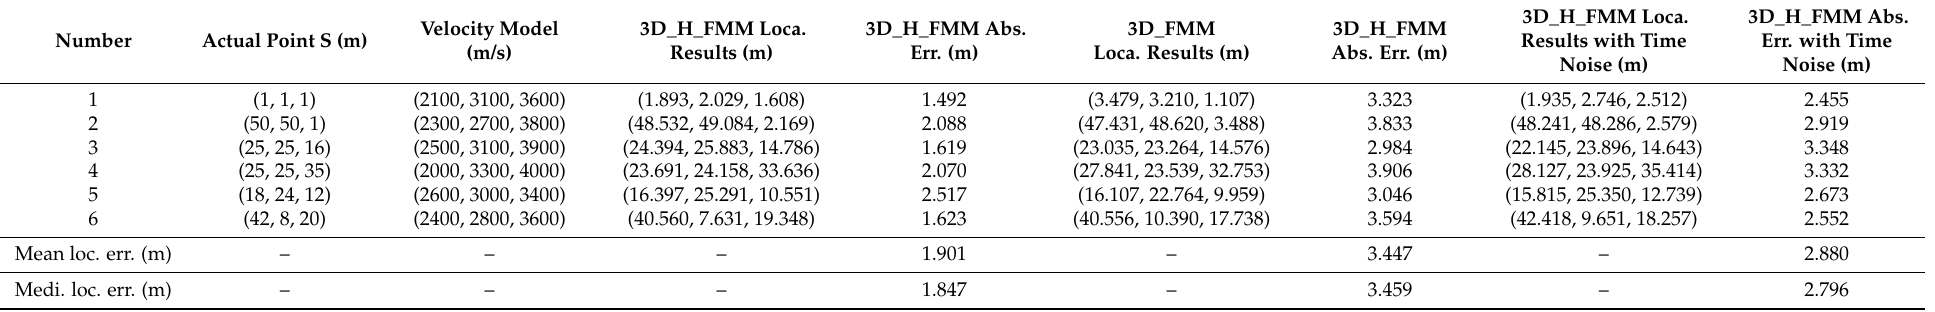
Table 7. The localization results of microseismic sources using travel times (calculated by 3D_H_FMM and 3D_FMM) and their noise-laden travel times with Case C: small-scaled inhomogeneous velocity